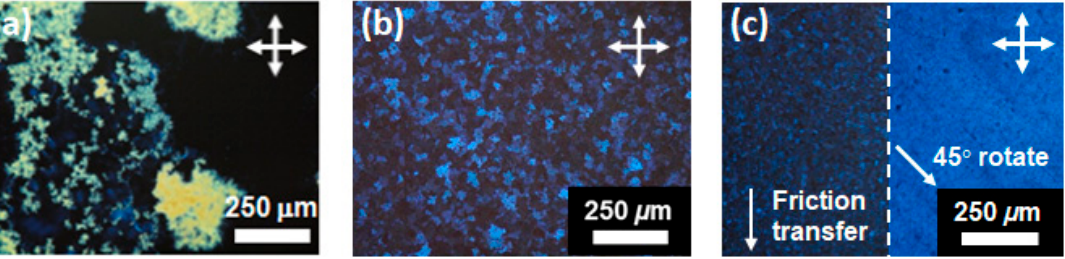
Figure 3. Polarizing optical micrographs of spin-coated thin films at room temperature in SmG*phases for ( a ) compound ( S ) − 2 on UV/O 3 -treated substrate, ( b ) compound ( S ) − 1 on UV/O 3 -treated substrate ( c ) compound ( S ) − 1 on friction-transferred substrate.